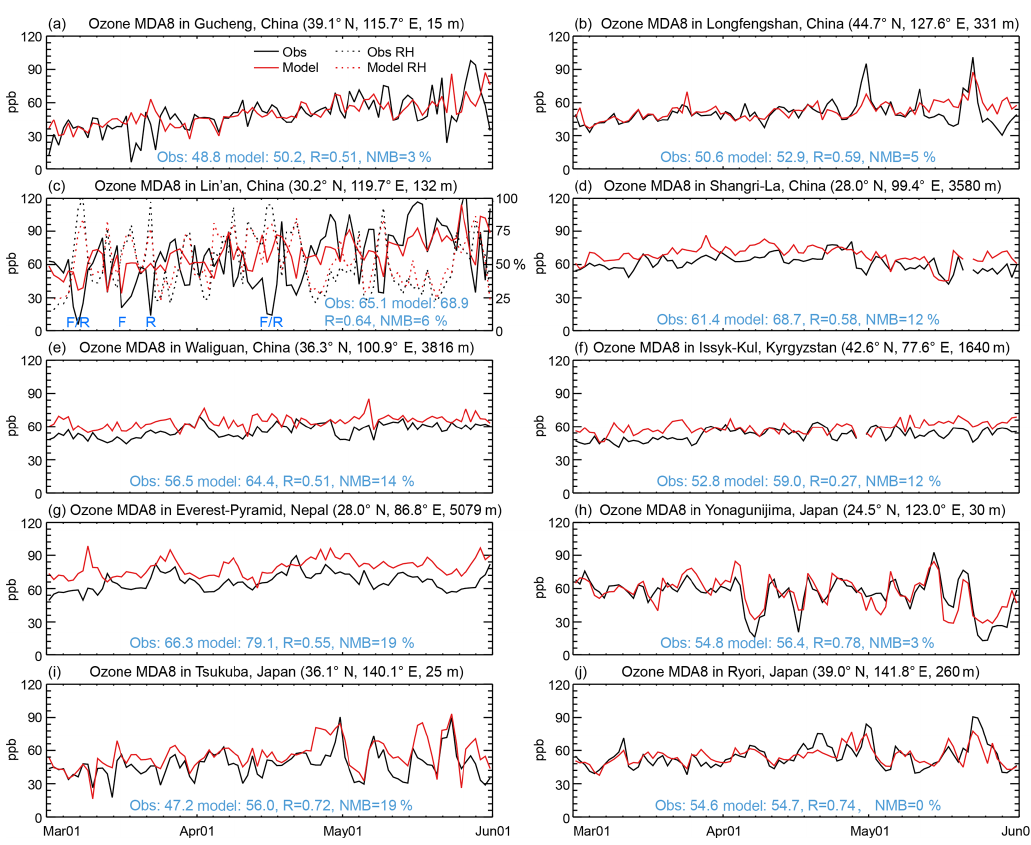
Figure 4. Time series of springtime MDA8 ozone at surface sites over (a–e) China and (f–j) nearby countries. Due to lack of measurement data in 2008, comparisons at Gucheng and Longfengshan are based on 2007. In (c) , observed and modeled RH are also compared, and the “F” and “R” symbols denote observed fog or rain, respectively.